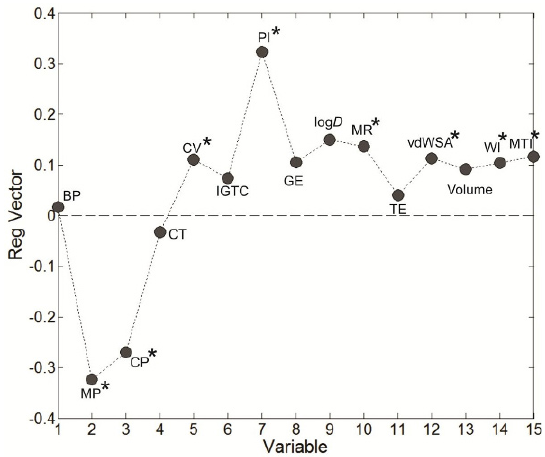
Figure 3. Graph of experimental versus predicted R M0 values according to PLS model.